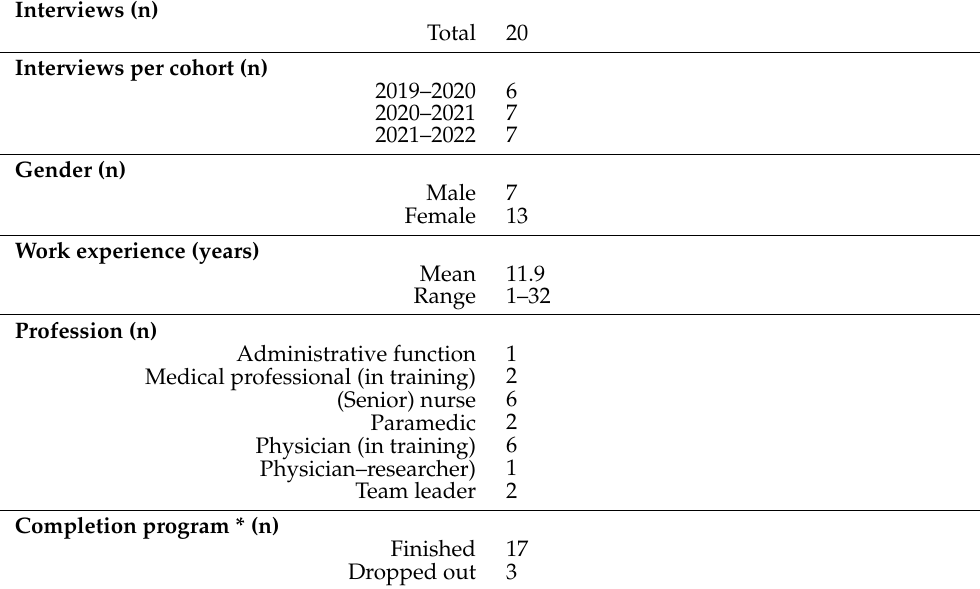
Table 1. Interview participants